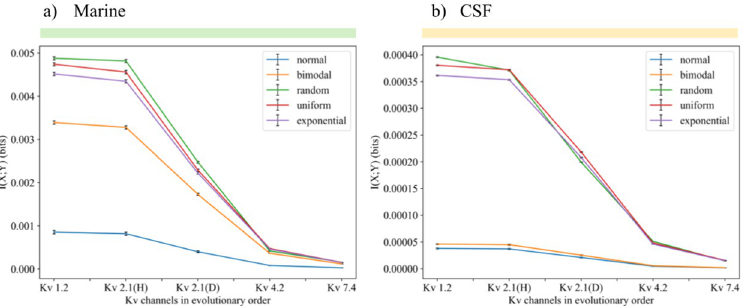
Fig 6. Mutual information in the evolutionary history of Kv channels. Mutual information in the evolutionary history of Kv channels always decreased in all environment distributions. The environment intervals are taken each 0.1 mM . a) real-life conditions of a primitive environment during the first evolutionary hotspot. b) real-life conditions of an evolved environment during second hotspot. Note the color correspondence with Fig 5. Note that the random, exponential, and uniform distributions are not affected in shape or steepness when changing the parameters. Kv2.1(H) is of mammalian type (Human) and Kv2.1(D) is invertebrate ( Drosophila melanogaster